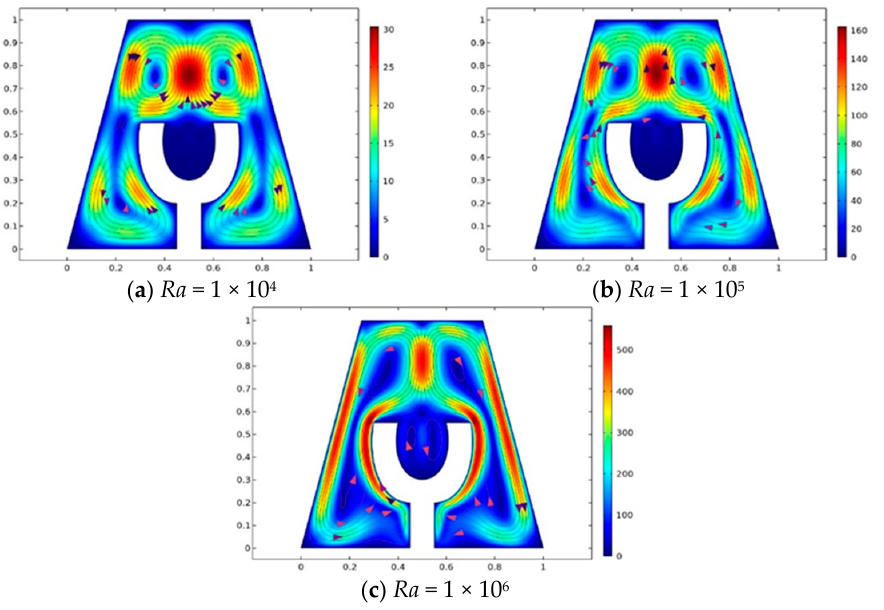
Figure 4. Velocity profiles and streamlines for varying Rayleigh number (𝑅𝑎) at 𝑛 = 1 and 𝑃𝑟 = 5